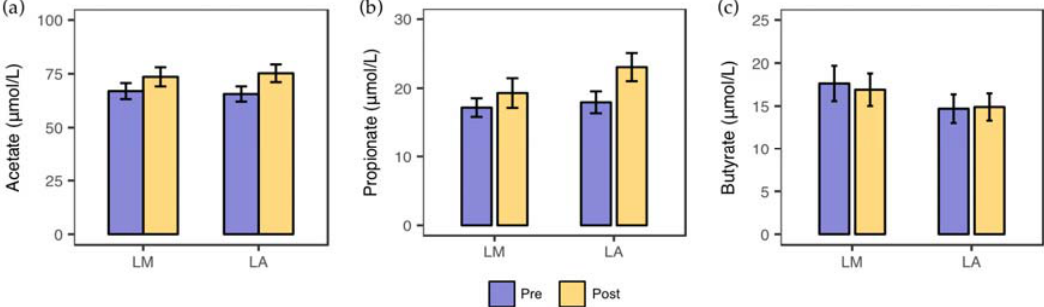
Figure 4. Fecal concentrations of short-chain fatty acids before and after whole milk supplementation in lactose malabsorbers (LM) and absorbers (LA). Fecal acetate ( a ), propionate ( b ), and butyrate ( c ) concentrations before and after four-week supplementation of whole milk in LM ( n = 31) and LA ( n = 31).